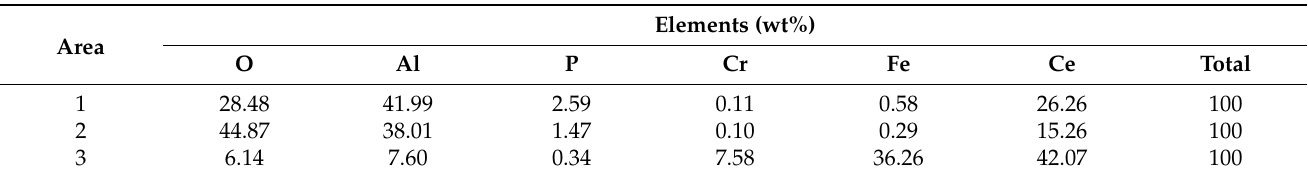
Table 4. Local elemental composition over the surface of the Fe-Cr-Al foil sample after heating at 900 ◦ C and phosphating at 400 ◦ C with a deposited secondary